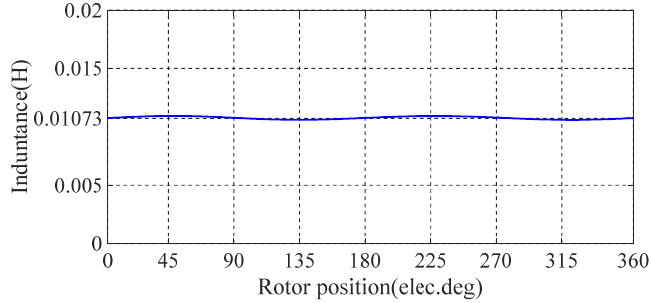
Figure 2. Testing result: the line inductance curve of the 3P-HSM.